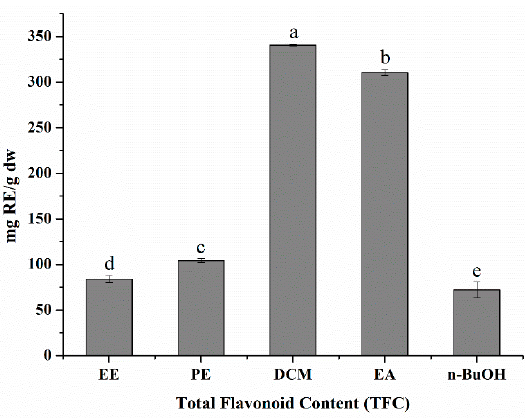
Figure 1. The total flavonoids content (TFC) of the ethanol extract and its fractions of S. doederleinii expressed rutin equivalents (RE) of dry weight sample. EE, ethanol extract; PE, petroleum ether; DCM, dichloromethane; EA, ethyl acetate; n-BuOH, n-butanol. All the data were expressed as mean ± standard deviation ( n = 3). The letters (a–e) denote that the means are significantly different at a level of p < 0.05 ( n = 3) by one-way ANOVA DMRT.